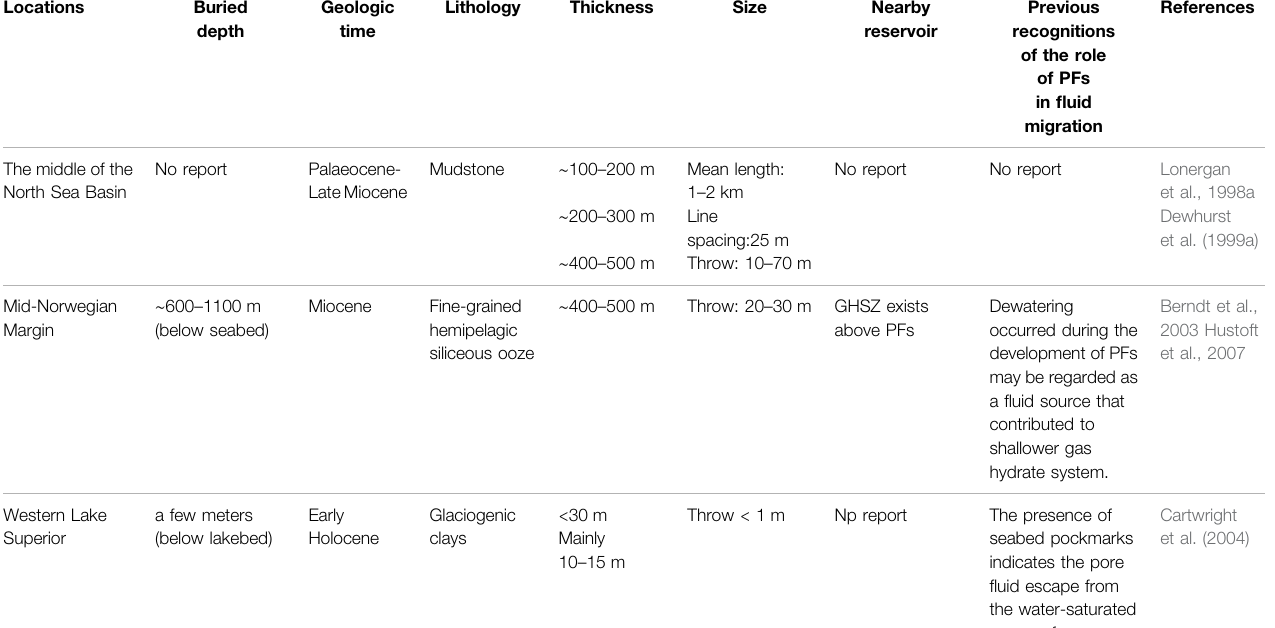
TABLE 2 | A compilation of global case studies of PFs showing information on location, buried depth, geological time, lithology, thickness, size, related hydrocarbon reservoirs, and the role of PFs in fl uid migration.